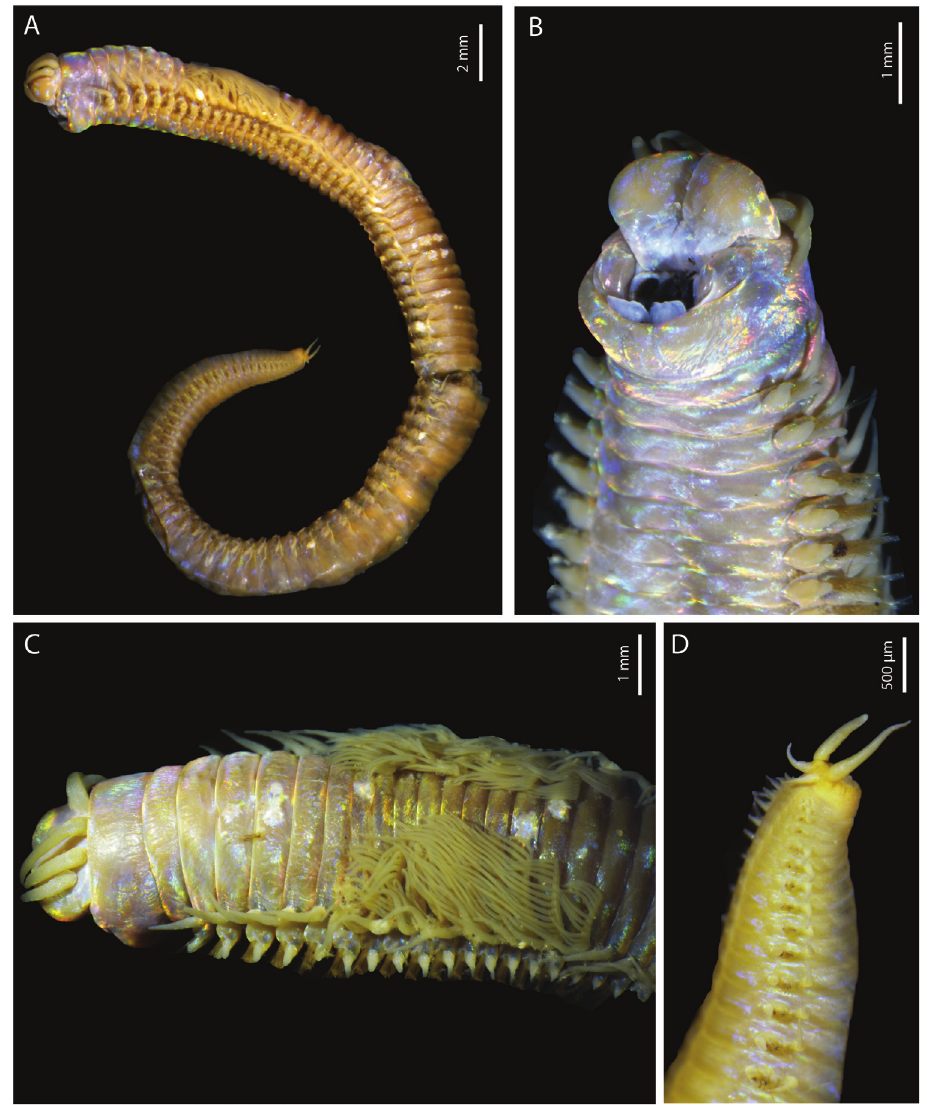
Figure 5. Marphysa papuaensis sp. nov. holotype MNHN-IA-2015-1559: A entire specimen, lateral view B anterior end, ventral view C anterior end, dorsal view D pygidium, lateral